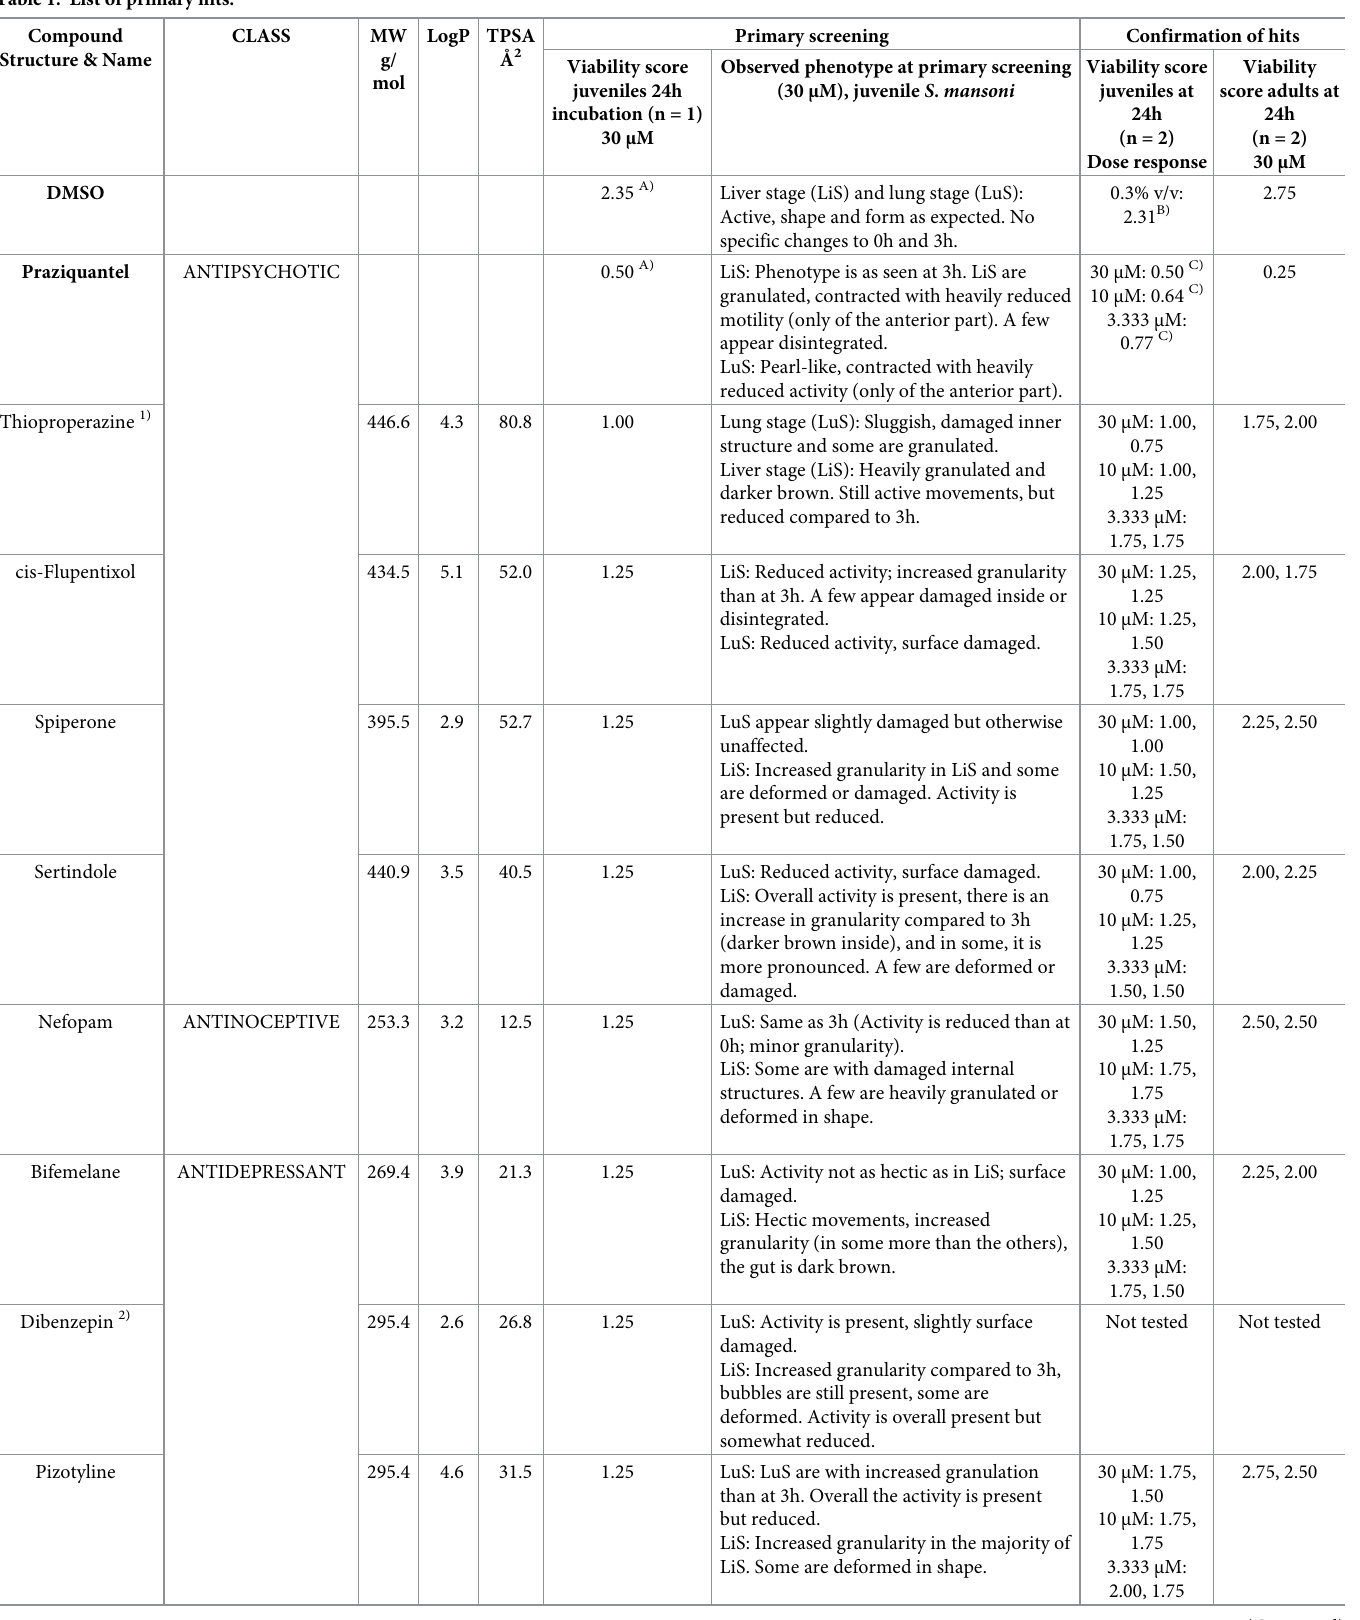
Table 1. List of primary